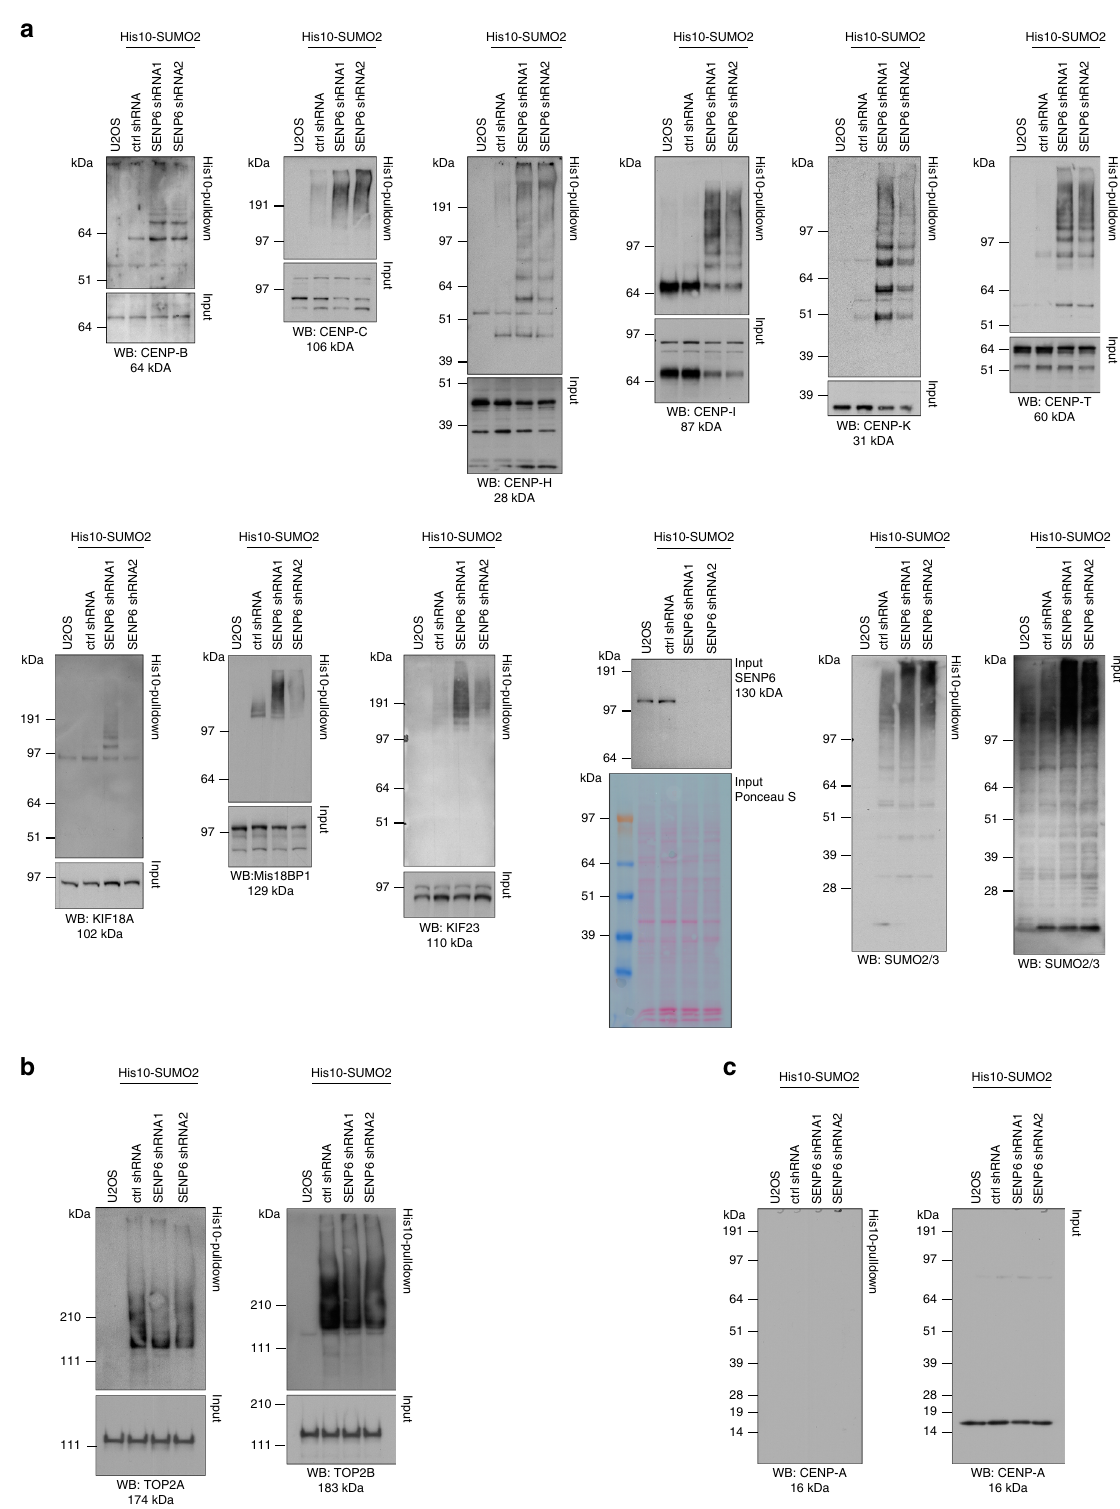
Fig. 4 Immunoblot validation of proteins identi fi ed by mass spectrometry. a U2OS cells stably expressing His10-SUMO2 were infected with lentiviruses encoding shRNAs against SENP6 or a nontargeting control shRNA (ctrl shRNA). Cells were lysed 3 days post infection and SUMOylated proteins were enriched by means of Ni-NTA pulldown. Inputs and His10-pulldown elutions were analysed by immunoblotting with the indicated antibodies. SENP6 and SUMO antibodies were used as control for ef fi cient knockdown of SENP6 and increase of SUMO conjugates. b Samples as in a were analysed by immunoblotting against Topoisomerases II α (TOP2A) and II β (TOP2B) that did not show increased SUMOylation in the mass spectrometry screening. c Samples as in a and b were analysed by immunoblotting against CENP-A. Source data are provided as a Source Data fi